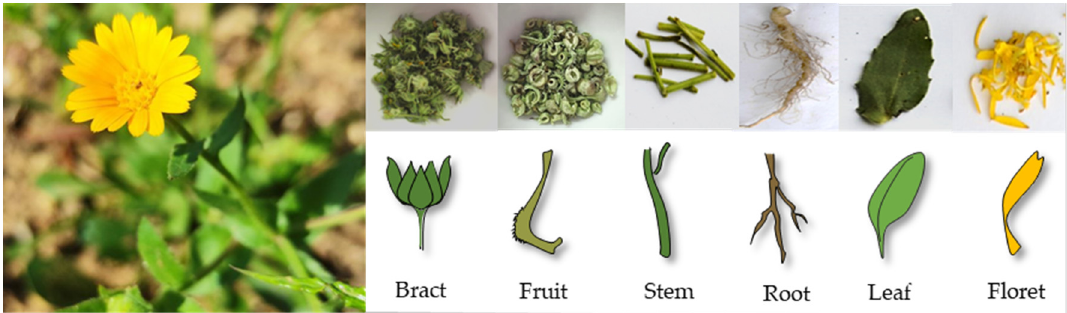
Figure 1. Calendula arvensis and its selected studied organs.